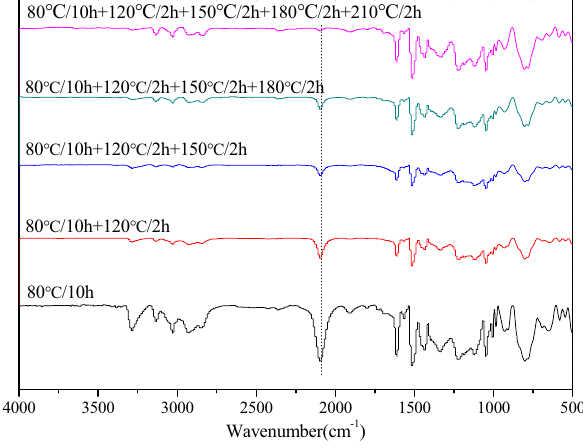
Figure 5: FT - IR spectra of OADTP - PTA - 16 resin at di ff erent curing stages.